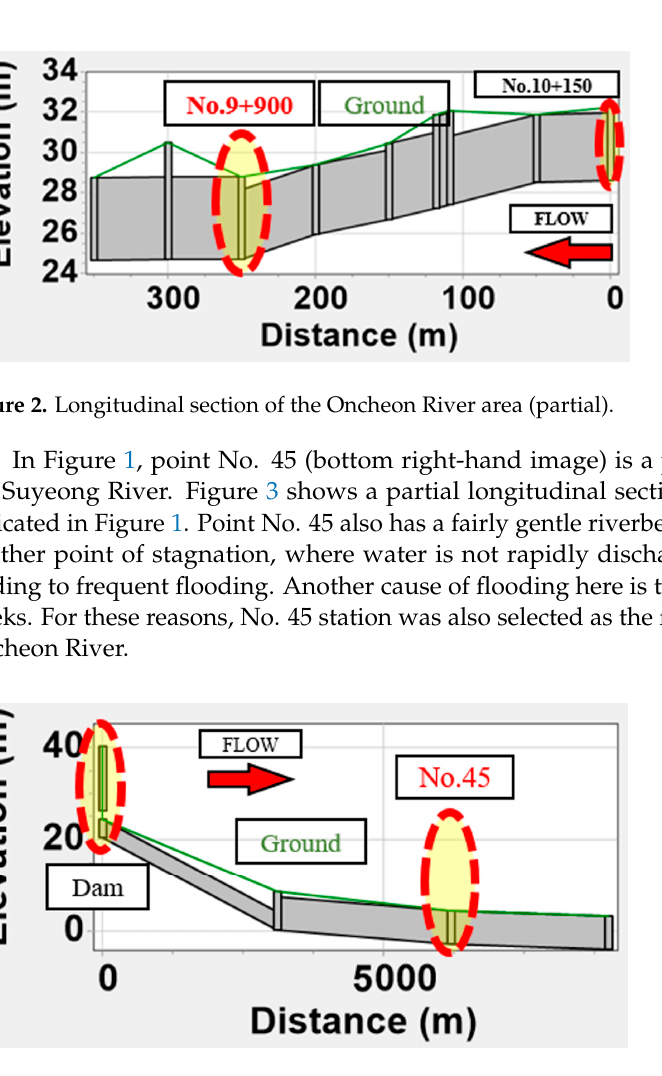
Figure 1. Study area. Point No. 10+150: 35°15’19.28” N, 129°5’40.11” E; Point No. 9+900: 35°15’12.78” N, 129°5’34.48” E; Point No. 9+800: 35°15’8.47” N, 129°5’31.49” E; Point No. 45: 35°11’5.73” N, 129°7’0.96” E.